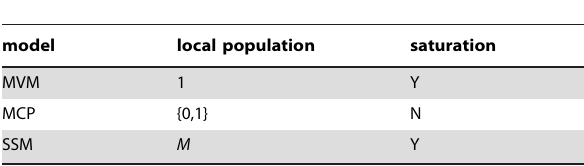
Table 1. Summary of